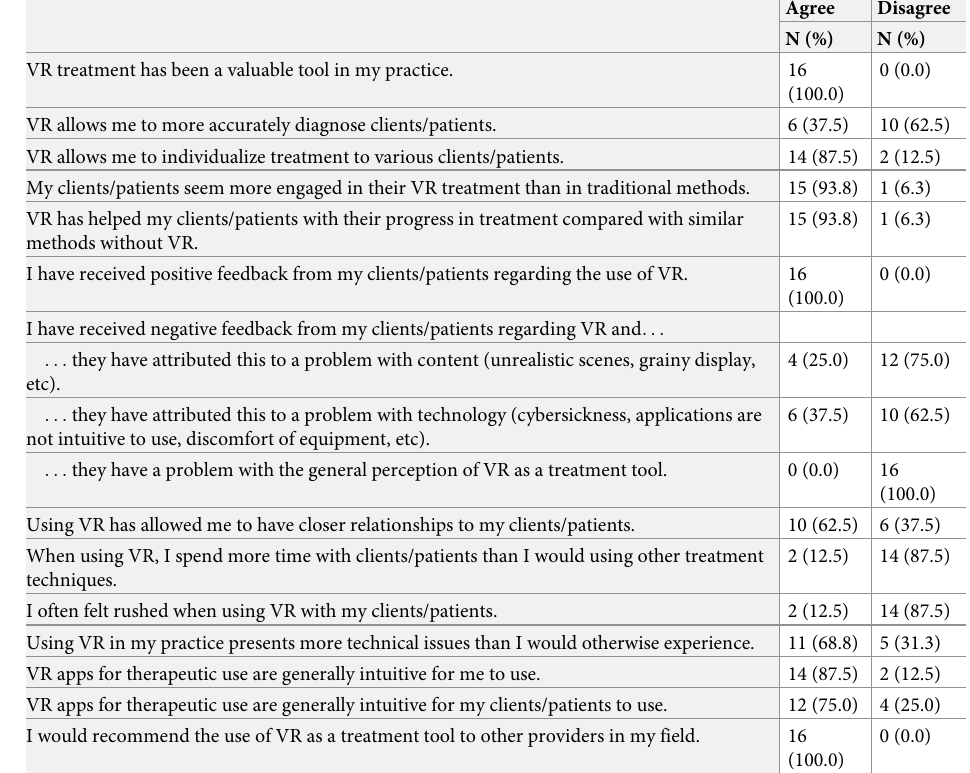
Table 2. Provider perceptions of VR value in clinical practice. VR treatment has been a valuable tool in my practice. 16